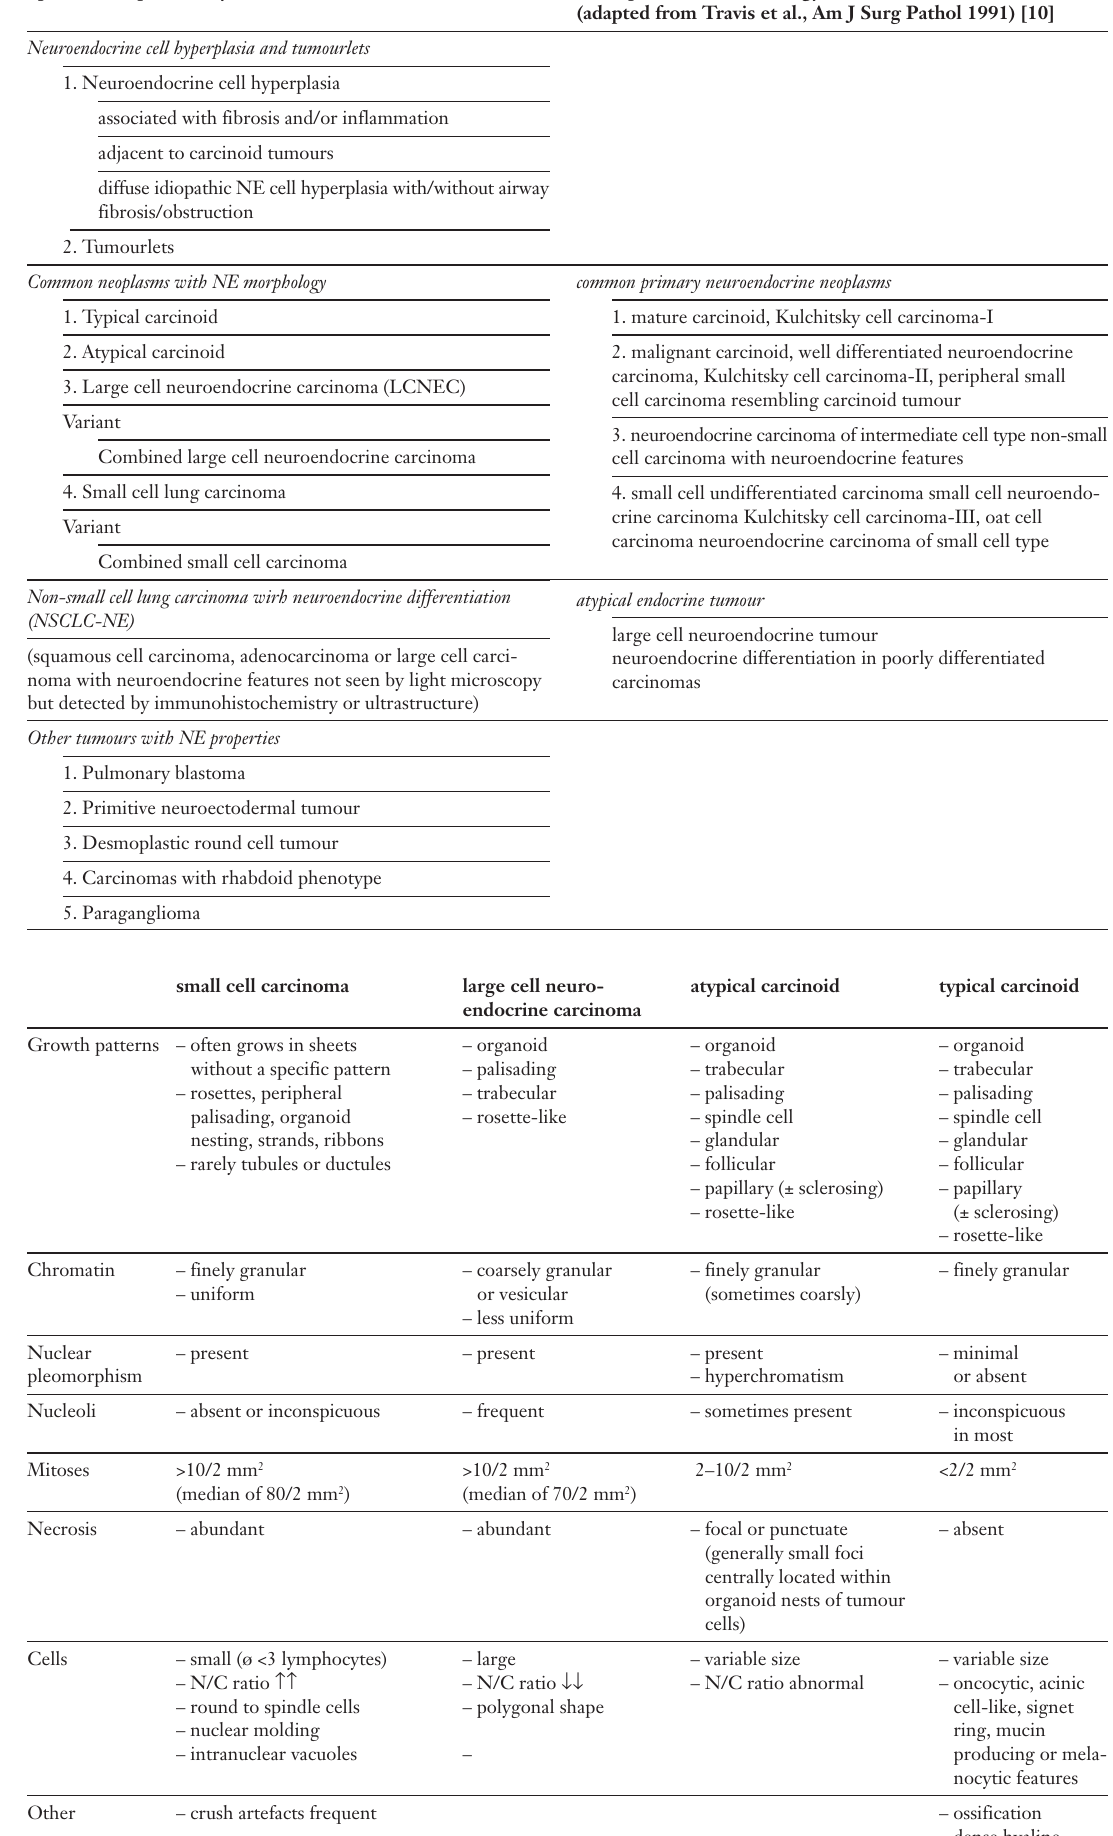
Terminology for pulmonary neuro- endocrine tumours (WHO 1999).